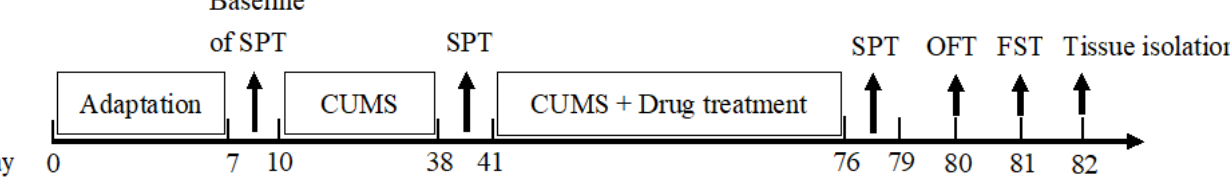
Figure 9. Schedule of the experimental